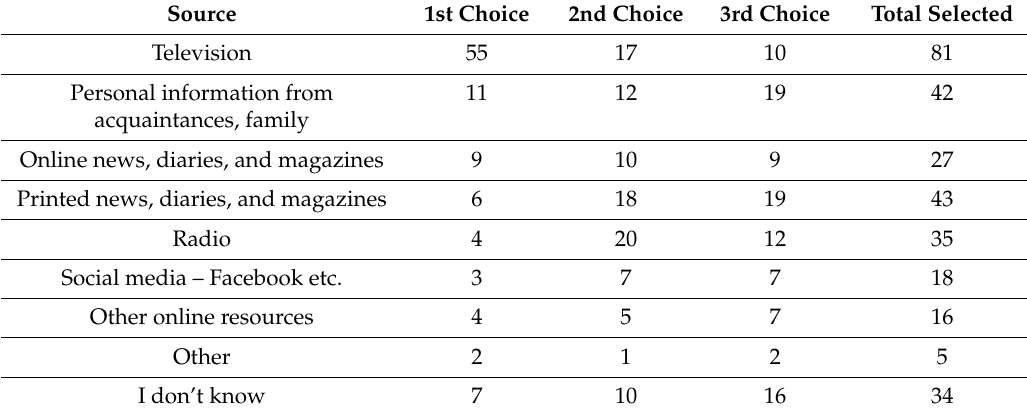
Table 2. Which of the following sources of information do you consider to be the most important for yourself in terms of information on forests and forestry? (data in %, source A2018).